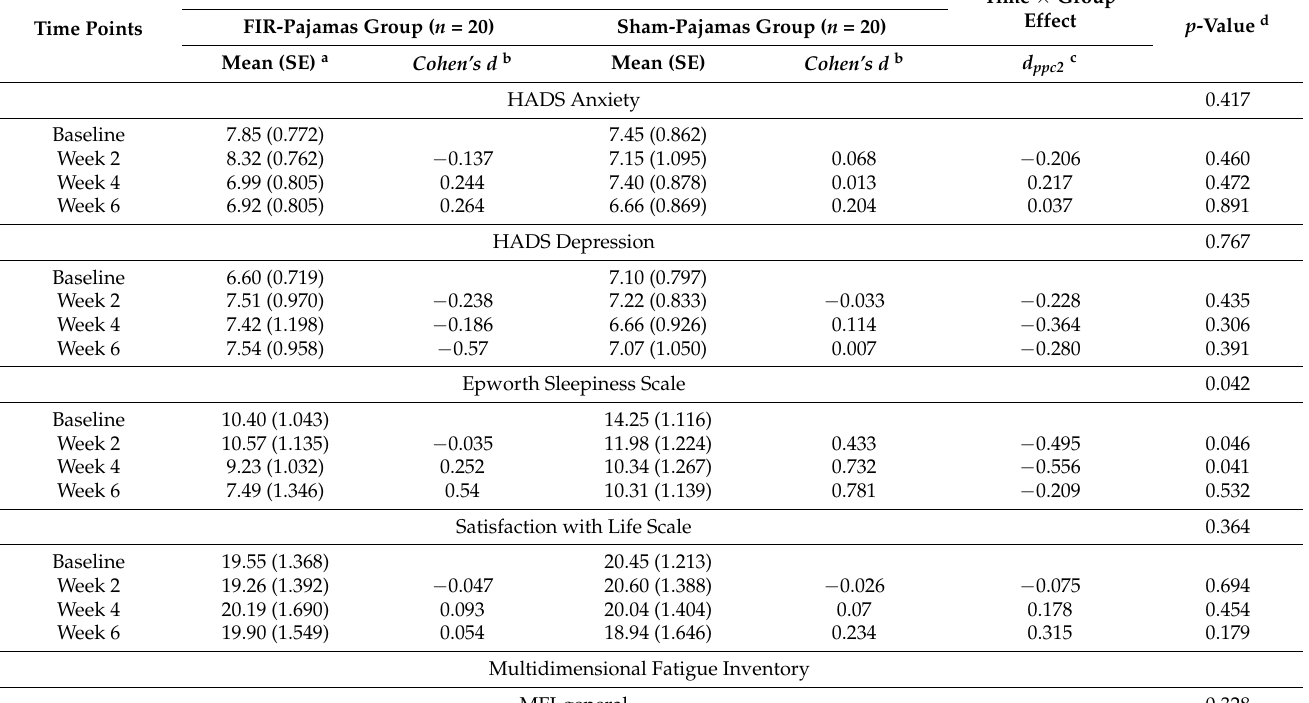
Table 3. Intervention effects on other outcomes across study time-points obtained using the